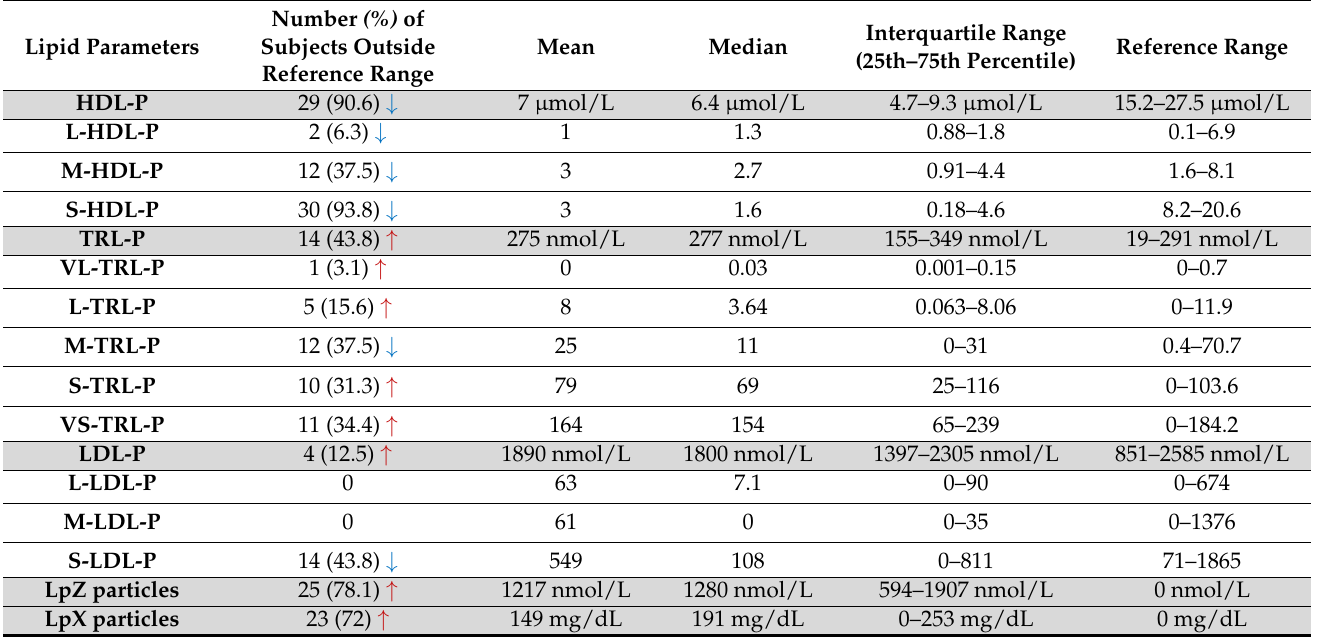
Table 2. Tabular summary of the lipoprotein profiles of all participants in the